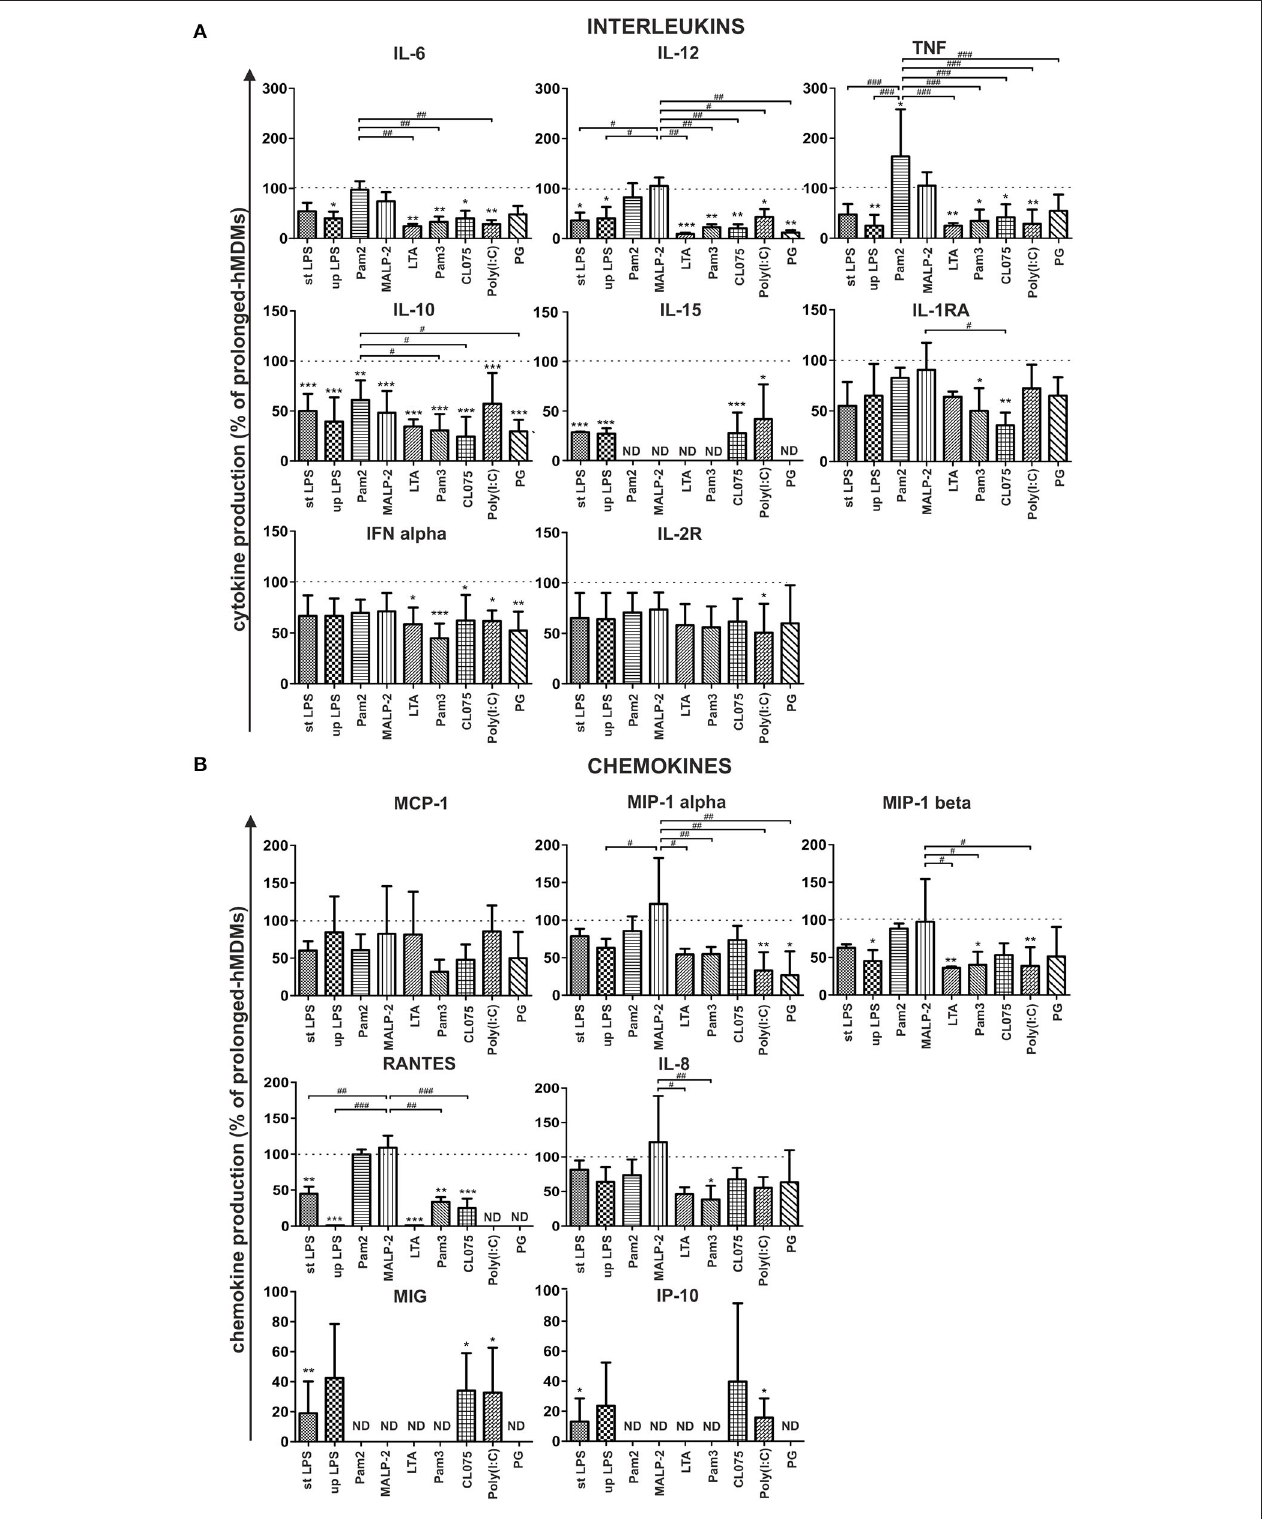
FIGURE 5 | Effect of prolonged culture with oxLDLs on PAMPs-induced cytokine (A) and chemokine (B) production. Prolonged-hMDMs and hMDFCs were obtained as indicated in Materials and Methods, and Figure 1 . Cells were then stimulated with different PAMPs for 24h. Levels of cytokines in supernatants were determined by a multiplex immunoassay and normalized to protein concentration in corresponding cell cultures. Results for prolonged-hMDFCs were expressed as a percent of